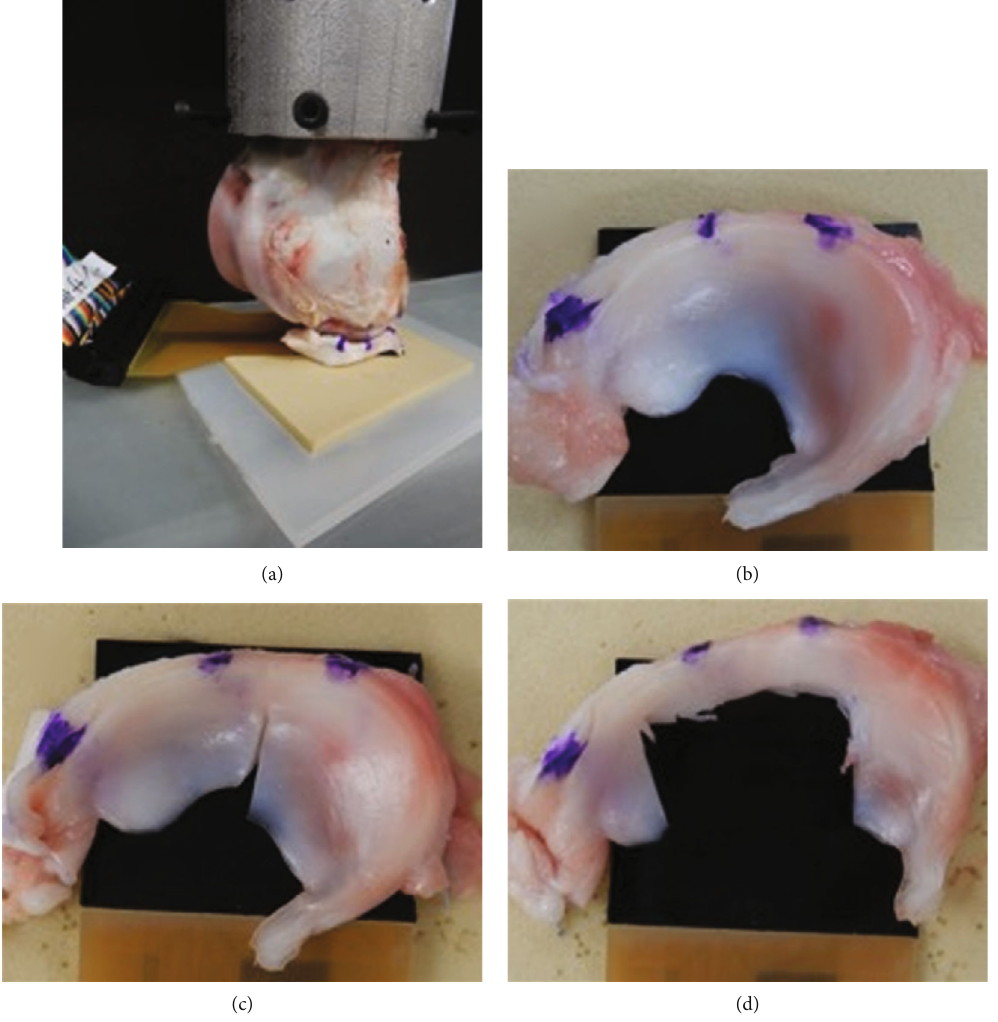
Figure 3: (a) Test setup in the universal testing machine to evaluate the contact pressure and area under loads. (b) Representative images of intact, (c) radial tear extending 90%, and (d) partial meniscectomy involving the central 60% of the medial (Figure 3(c)), and (3) meniscectomy of the central 60% (Figure 3(d)).